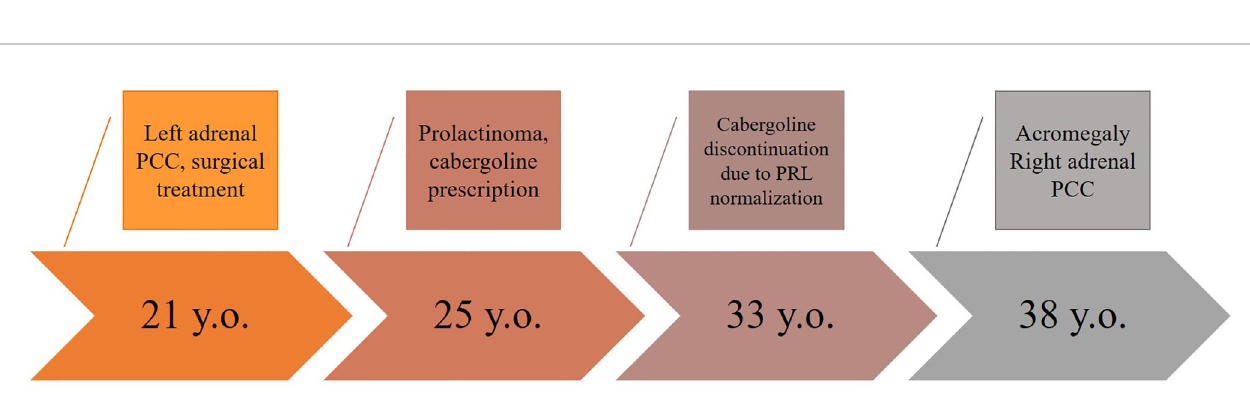
FIGURE 2 | Timeline of disease